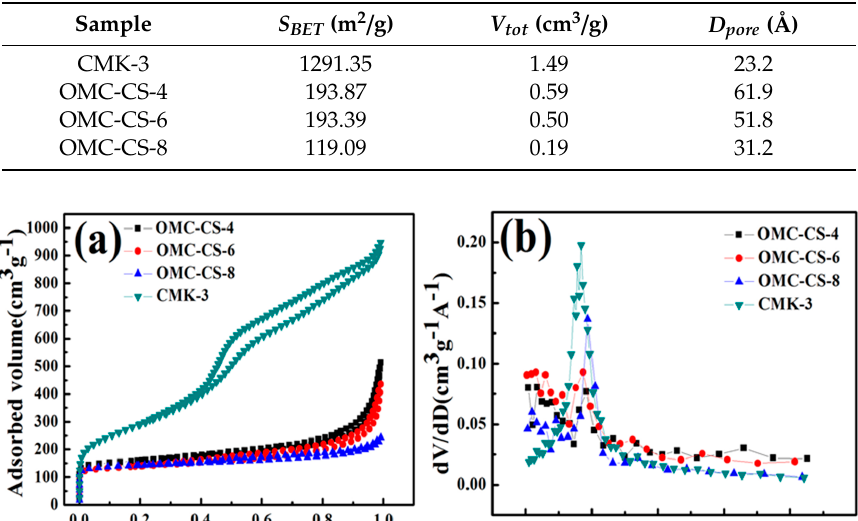
Figure 3. ( a ) Nitrogen adsorption-desorption isotherms at 77 K of CMK-3 and OMC-4,6,8, ( b ) Pore size distribution of CMK-3 and OMC-4,6,8.